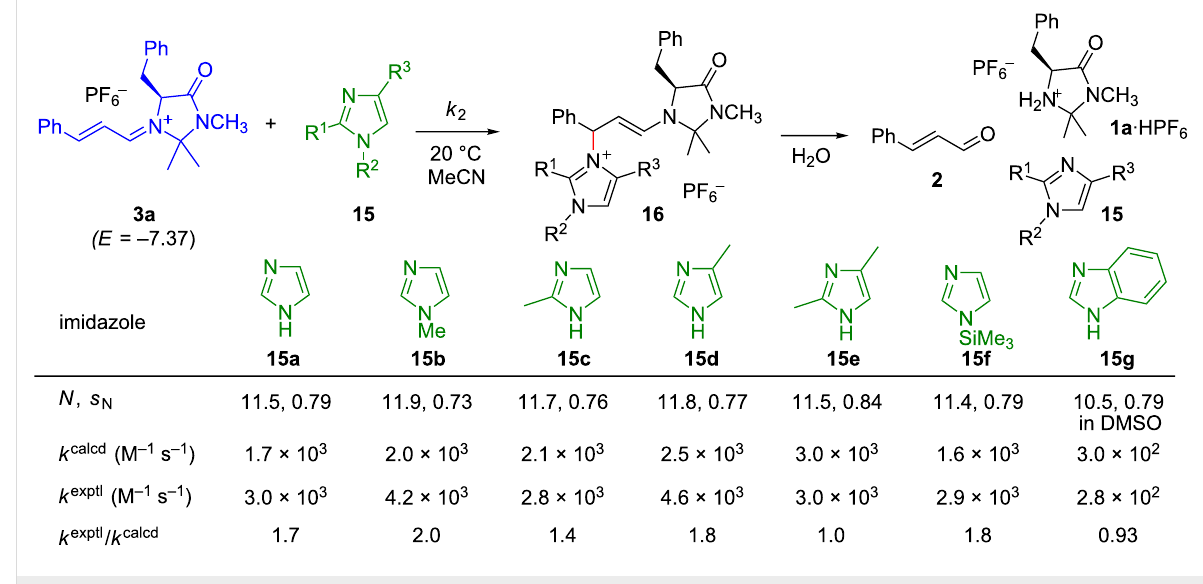
Figure 10: Aza-Michael additions of the imidazoles 15 with the iminium ion 3a [58].